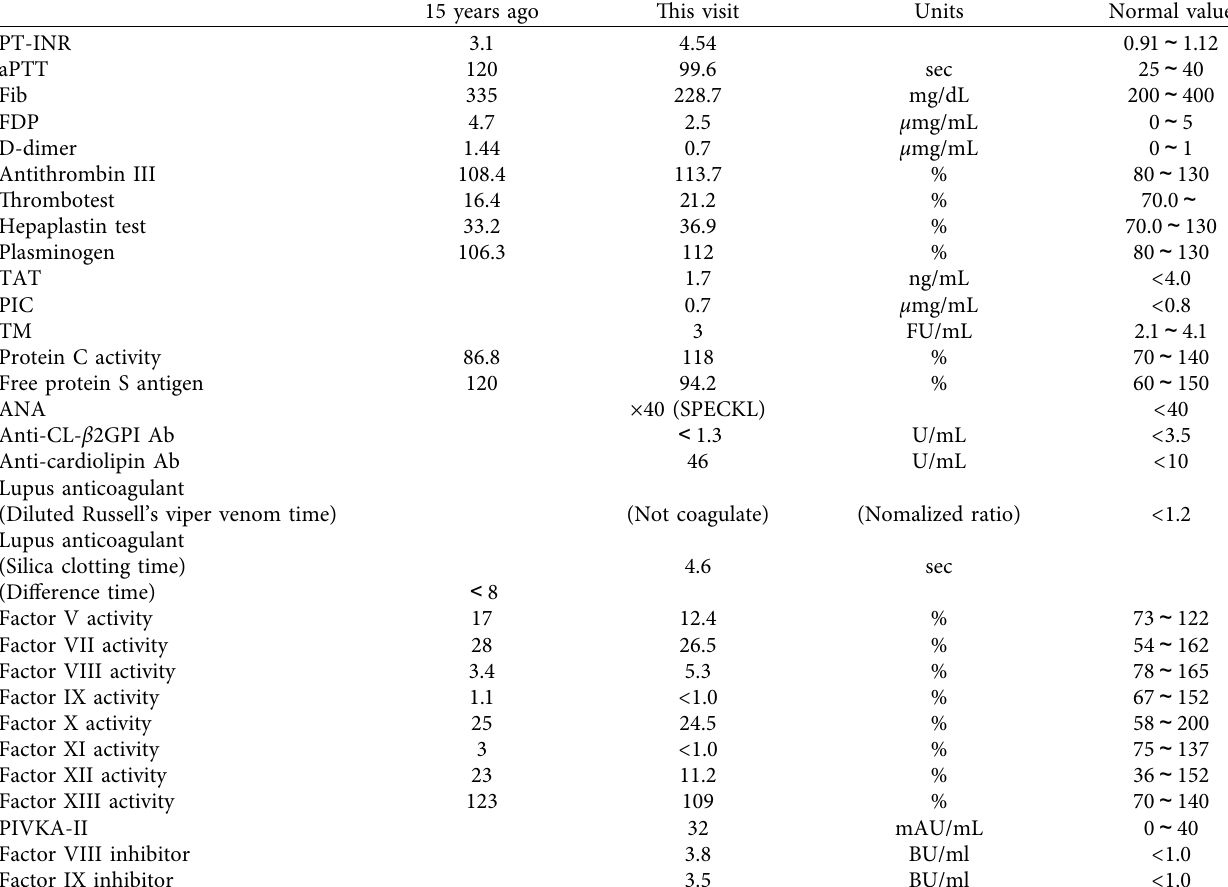
Table 1: The main blood test of coagulation system at the university hospital 15 years ago and this visit.